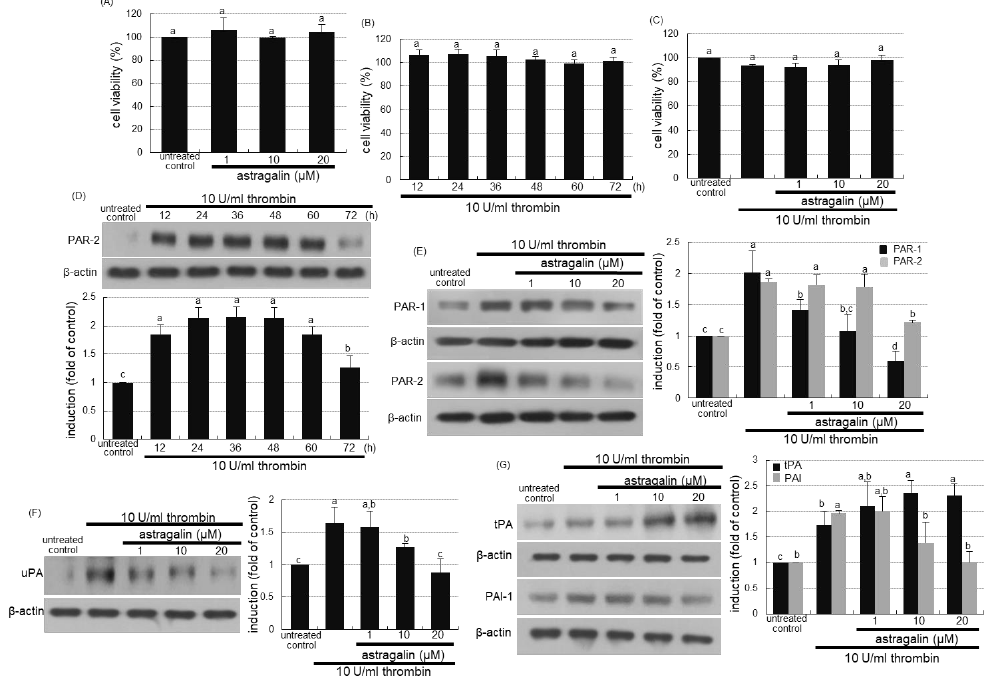
Figure 4. Cytotoxicity of astragalin and thrombin ( A – C ), and temporal expression ( D ) and inhibition ( E ) of protease- activated receptor (PAR) proteins, and inhibition of urokinase plasminogen activator (uPA, ( F )), and modulation of tissue plasminogen activator (tPA) and plasminogen activator inhibitor-1(PAI-1, G) in thrombin-exposed A549 cells with and without 1 –20 μM astragalin. Alveolar epithelial cells were incubated in media containing 10 U/mL thrombin in the absence and presence of 1 –20 μM astragalin for up to 72 h. A549 cell viability (mean ± SEM, n = 5) was measured by using MTT assay and expressed as percent cell survival relative to untreated controls ( A – C ). Cell lysates were prepared for Western blot analysis with a primary antibody against PAR-1, PAR-2, uPA, tPA and PAI-1 ( D – G ). The bar graphs (mean ± SEM, n = 3) represent quantitative results of the upper left bands obtained from a densitometer. β -Actin protein was used as an internal control. Values in bar graphs (same achromatic colored) not sharing the same lower case alphabet letter indicate a significant difference at p < 0.05.